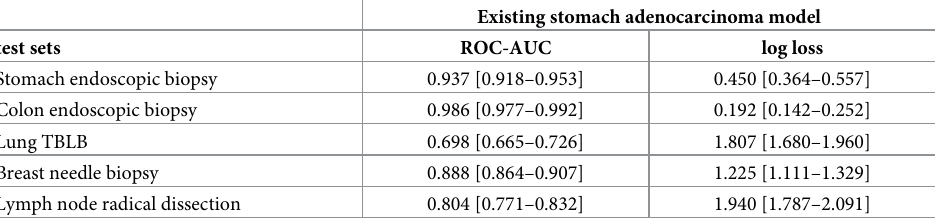
Table 5. ROC-AUC and log loss results for adenocarcinoma classification on test sets using existing stomach ade- nocarcinoma classification